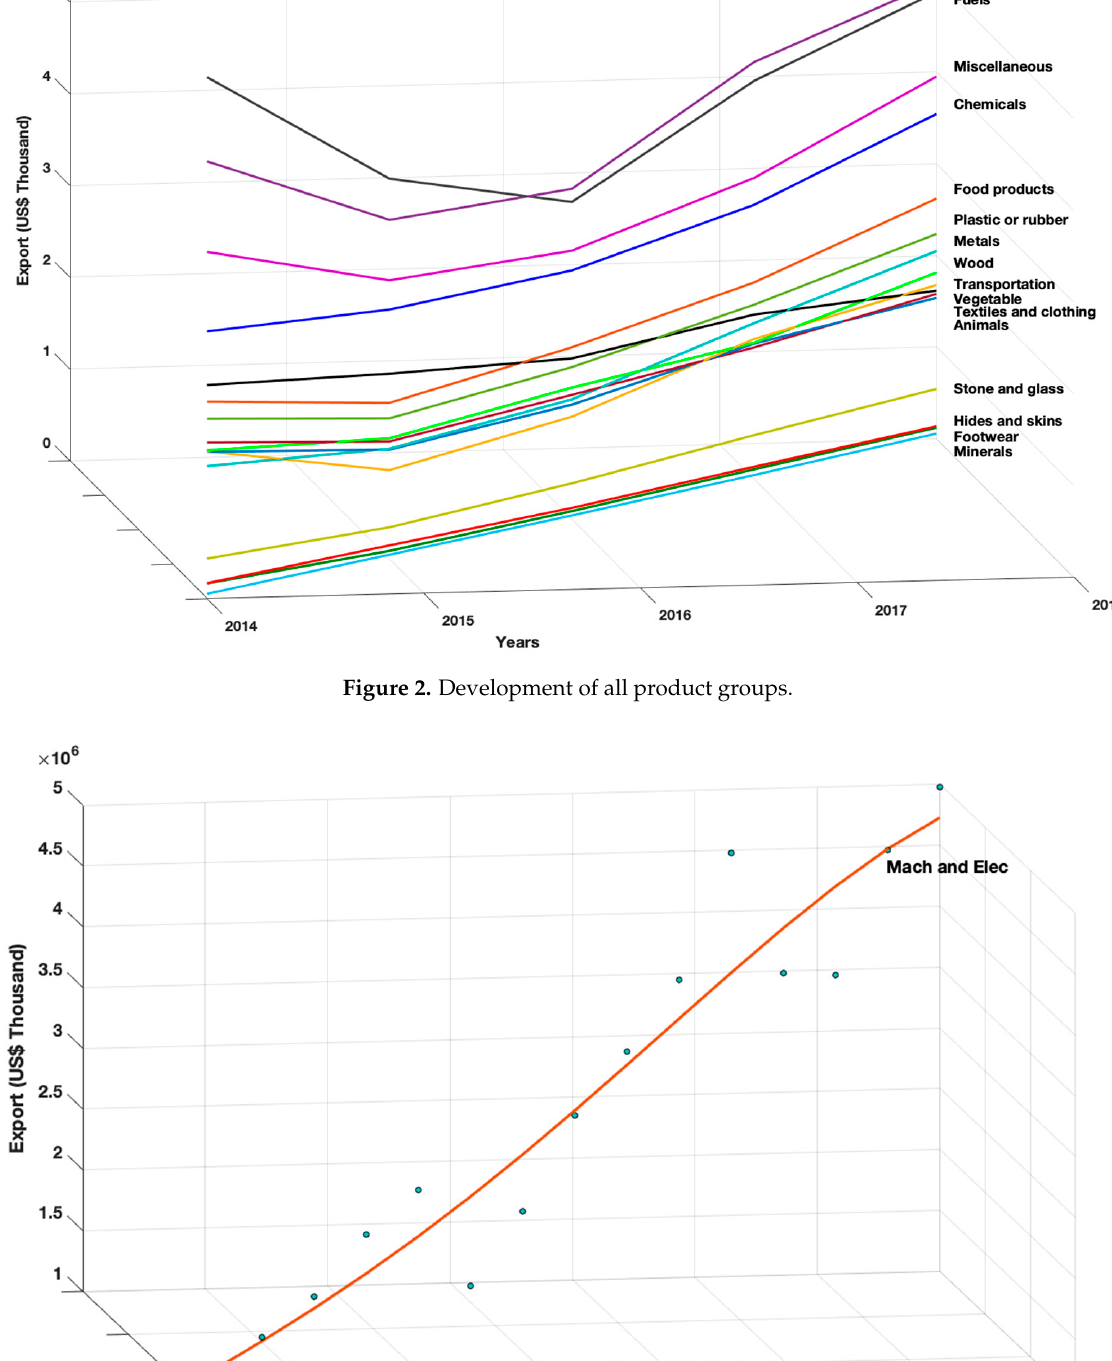
Figure 3. The degree 4 polynomial.